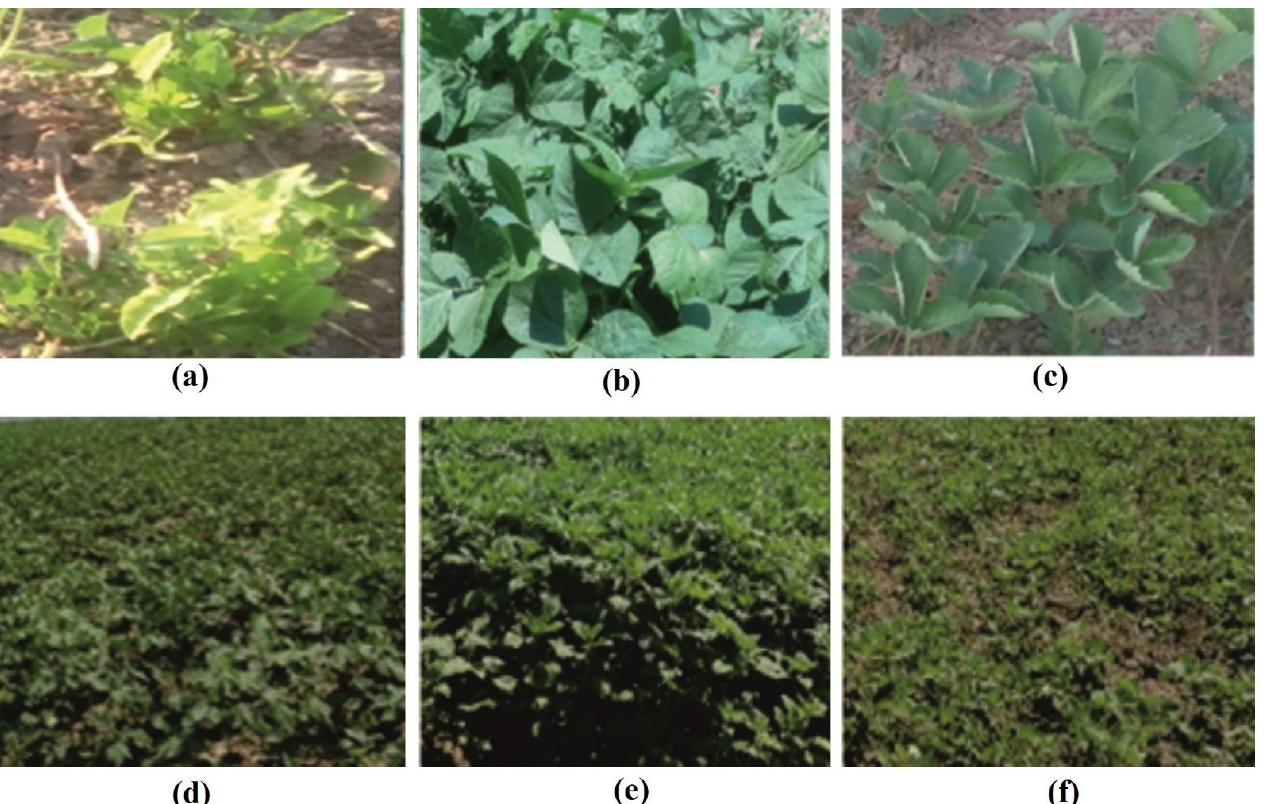
Figure 2. Sample images: ( a ) water spinach, ( b ) soybean, ( c ) strawberry, ( d ) corn, ( e ) sesame, and ( f ) broad-leaf soybean.